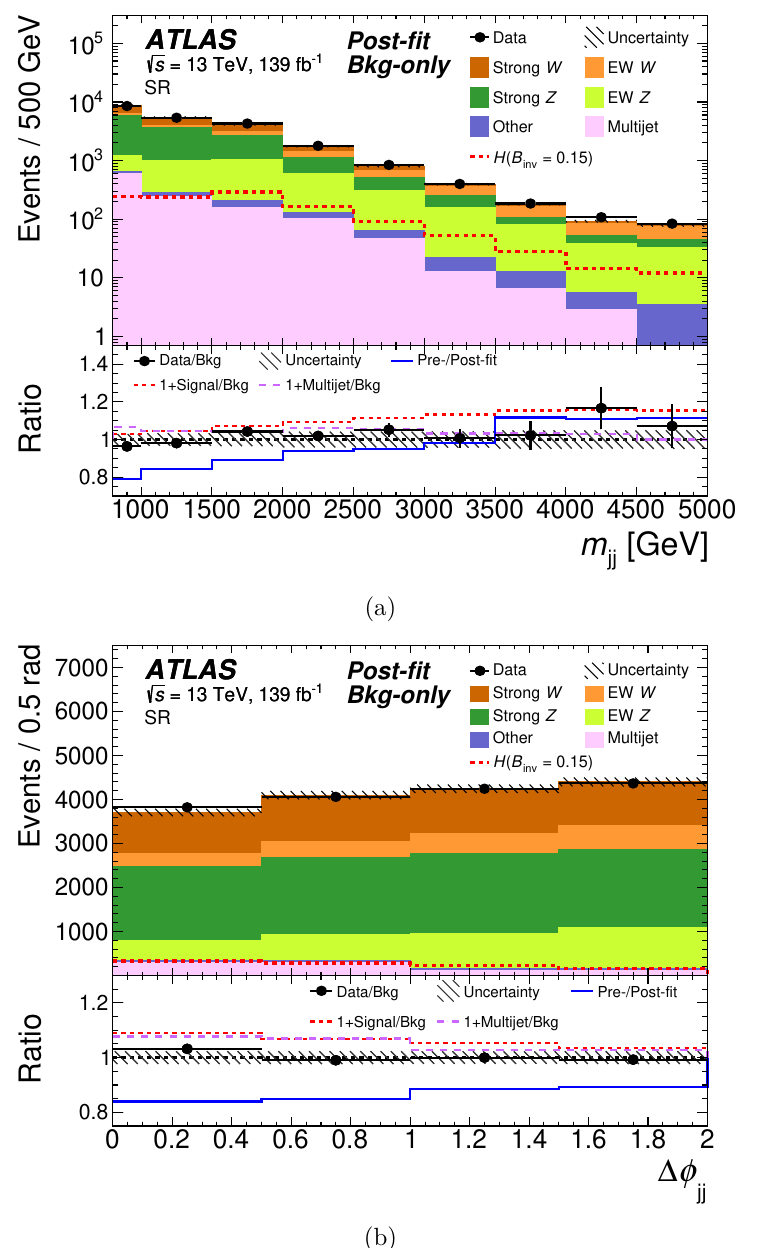
Figure 12. Post-fit (a) m jj and (b) ∆ φ jj distributions in the inclusive signal region. Minor contributions from t ¯ t , V V , V V V , and VBF H with H → τ + τ − or H → W ∗ W are combined and labelled ‘other’. The signal (dashed red line) is scaled to a branching ratio of 15% for Higgs boson decays into invisible particles. In addition to the data-to-background ratio, the lower panels show the ratio of the background expectation before and after the likelihood fit, the relative size of the multijet background, and the signal-to-background ratio. The latter two quantities are shifted by one to use the same y -axis